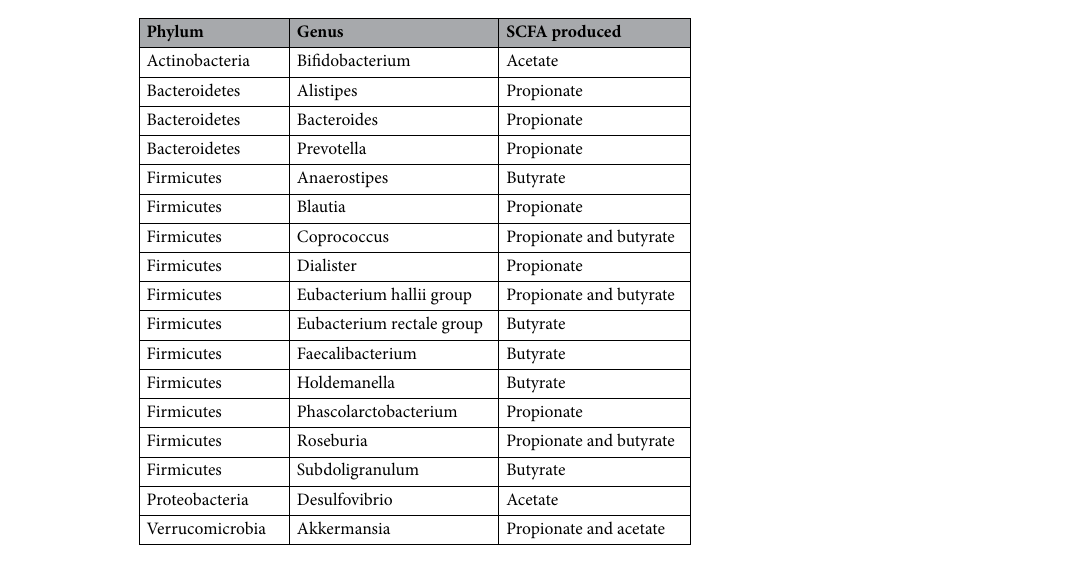
Table 2. Names of SCFA producers and their